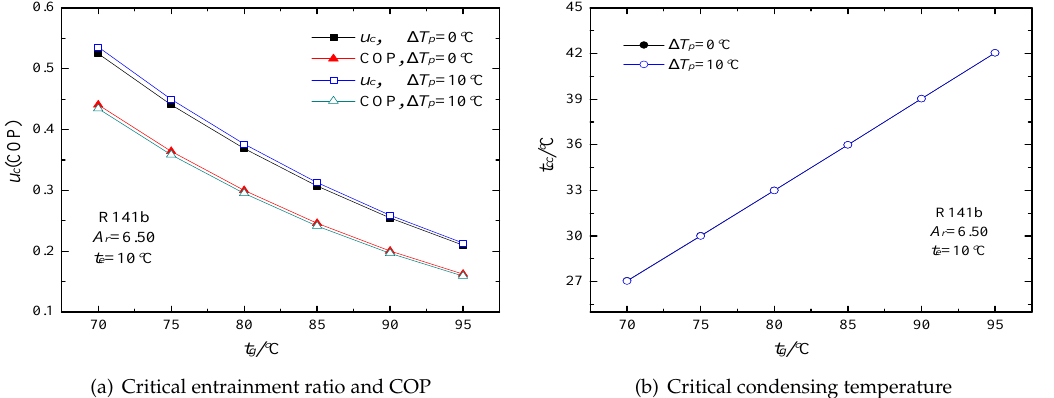
Figure 18. Critical entrainment ratio, COP and critical condensing temperature versus generating temperature using R141b as a working fluid.